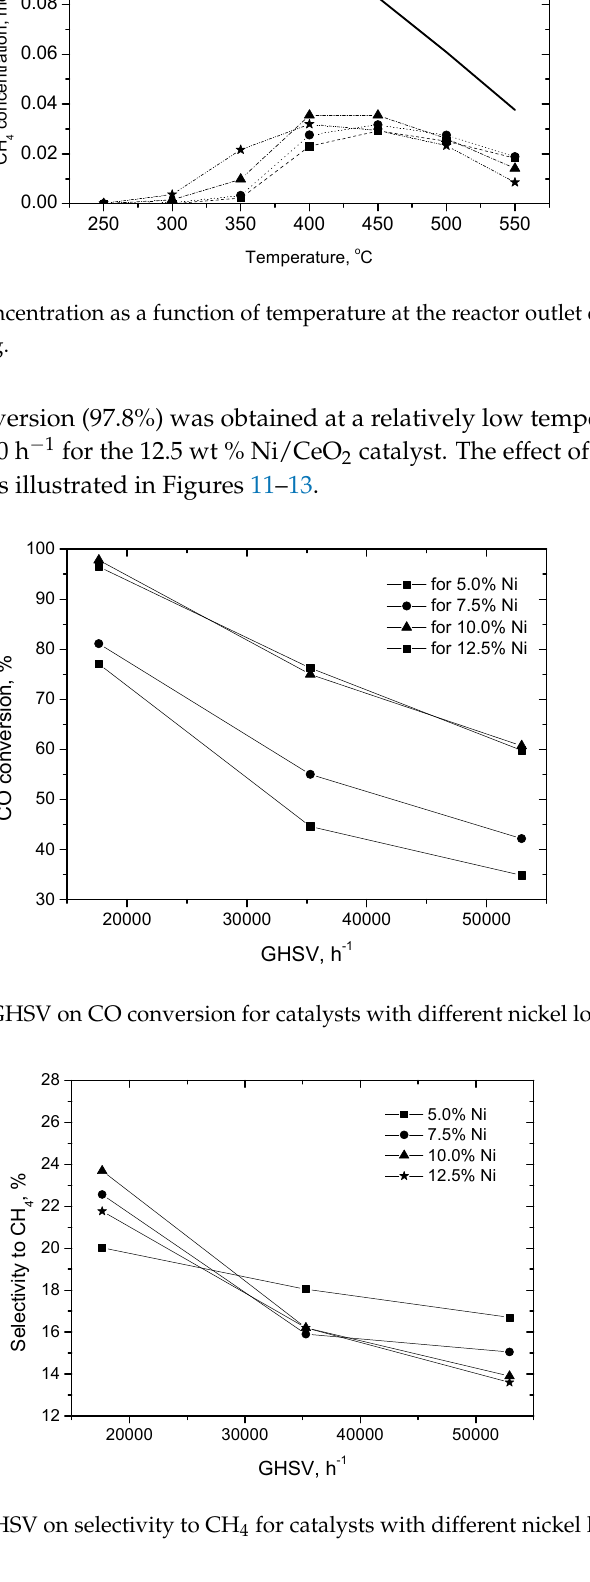
4 for catalysts with different nickel loading at 400